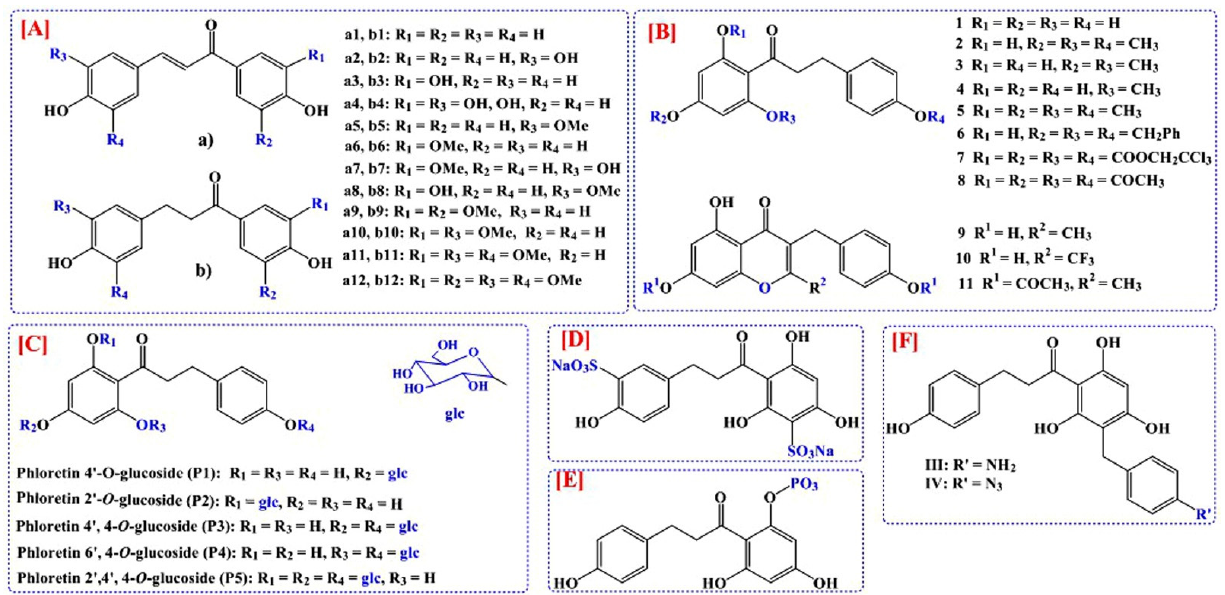
Figure 2. Some potential synthetic derivatives of phloretin: ( A ) Minsat et al. [56]; ( B ) Wang et al. [57]; ( C ) Pandey et al. [55]; ( D ) Shin et al. [54]; ( E ) Peerce et al. [59]; and ( F ) Diedrich [60].